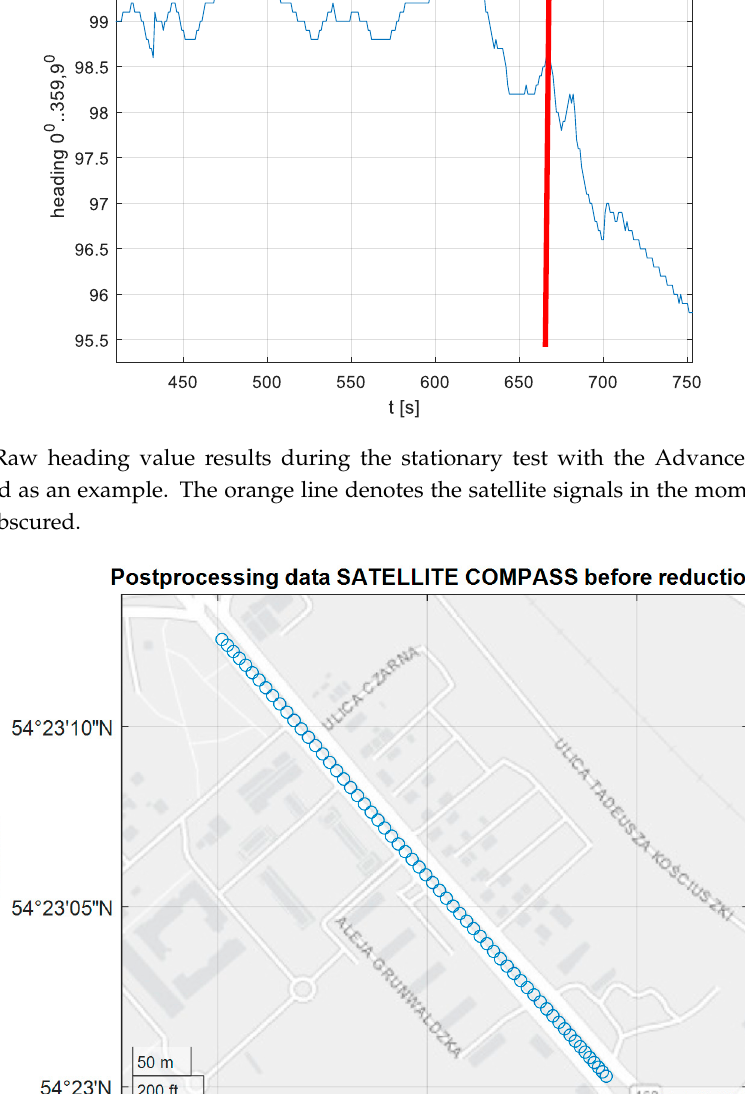
Figure 16. Raw heading value results during the stationary test with the Advance Navigation compass used as an example. The orange line denotes the satellite signals in the moment of being completely obscured.